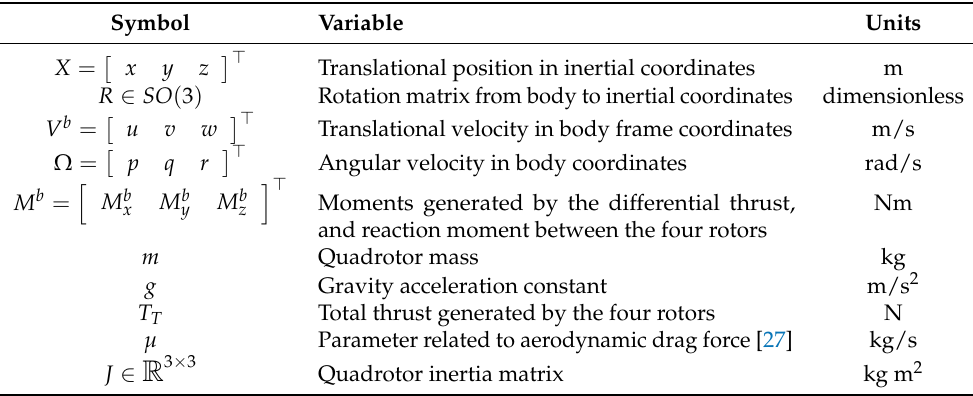
Table 1. Quadrotor dynamic model